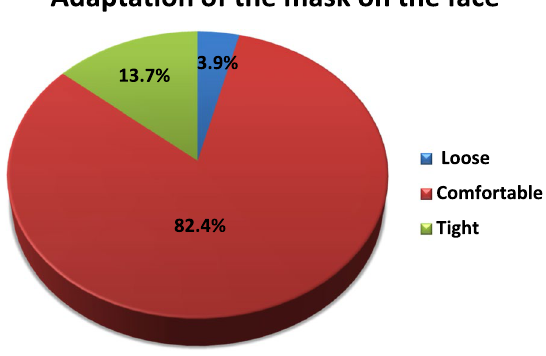
Fig. 2 Frequency of mask adaptation on the face among the study subjects